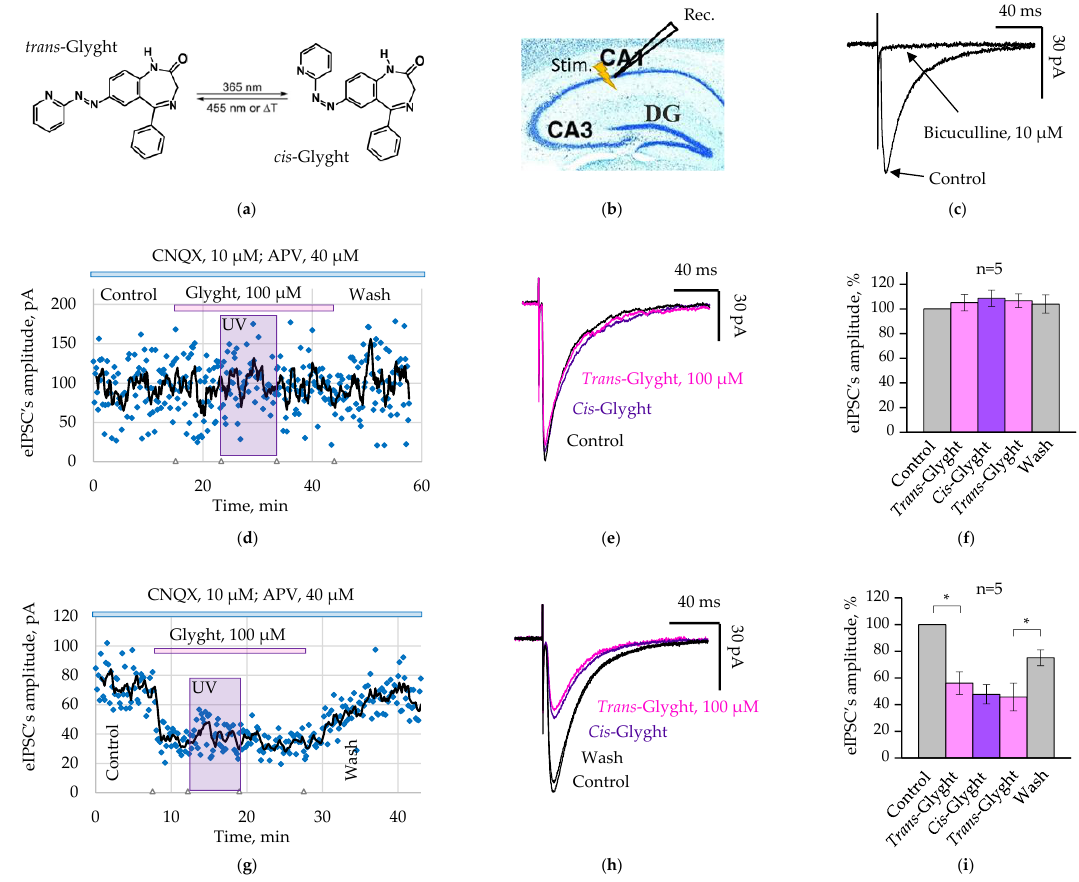
Figure 1. Analysis of Glyght action on the amplitude of the GABAergic eIPSCs in neurons of the hippocampal slices: ( a ) structural formula of Glyght in trans - and cis -configurations; ( b ) the scheme of location of the bipolar stimulating (Stim.) and the recording (Rec.) electrodes on the hippocampal slice; ( c ) evoked postsynaptic currents in control and in the presence of bicuculline (10 µM). Note that bicuculline completely blocked registered currents, confirming their GABAergic nature; ( d ) o riginal eIPSCs’ amplitude values are continuously displayed on the scatter plot with a 5-period moving-average trendline (black line), obtained from a Glyght resistant neuron; ( e ) example of su- perimposed traces of eIPSCs in the neuron resistant to Glyght; ( f ) normalized mean amplitudes of eIPSCs in cells resistant to Glyght. The conditions are indicated below the graph. Mean data from 4 mice (P9 – P15), n = 5; ( g ) Original eIPSCs’ amplitude values are continuously displayed on the scatter plot with a 5-period moving-average trendline (black line), obtained from a Glyght sensitive neuron; ( h ) superimposed examples of traces of eIPSCs in the neuron sensitive to Glyght. Note that the de- gree of inhibition by Glyght in trans - and cis -configuration are similar; ( i ) normalized mean ampli- tudes of eIPSCs in cells sensitive to Glyght. Mean data from two mice (P12, P13), n = 5. Data were normalized to control. Mean ± SEM. * Significant difference with p < 0.05 (paired Student’s t -test). 2. Results 2.1. Glyght Action on GABAergic Evoked Inhibitory Postsynaptic Currents Paired, with the interval of 200 ms, GABAergic evoked Inhibitory Postsynaptic Cur- rents (eIPSCs) were recorded from the mouse (P9 – P15) pyramidal cells of the hippocam- pal CA1 area using the whole-cell configuration of the patch-clamp technique at a holding potential of − 70 mV in the presence of CNQX 10 µM and D-AP5 40 µM. To excite GABAergic interneurons, the bipolar stimulating electrode was placed in the stratum ra- diatum in close proximity to the recorded cell (Figure 1b). Recordings were carried out